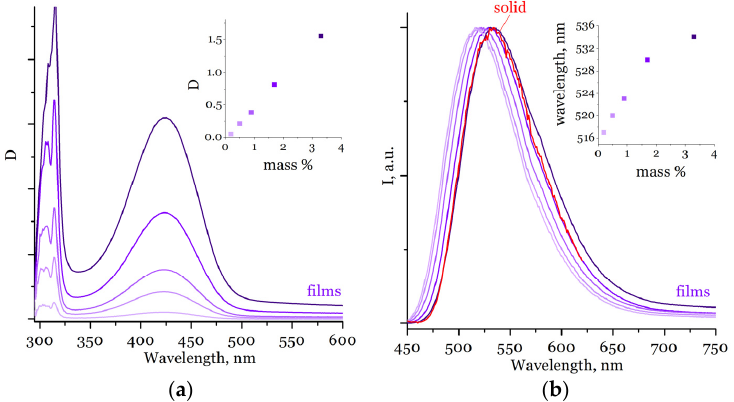
Figure 8. ( a ) Absorption spectra of polystyrene films containing 2 with a mass fraction from 0.2 to 3.3%. Inset shows absorbance (D) at 425 nm versus mass fraction. ( b ) The corresponding normalized PL spectra of the films and solid 2 α . Inset shows wavelength of the emission maximum versus mass fraction of 2 .